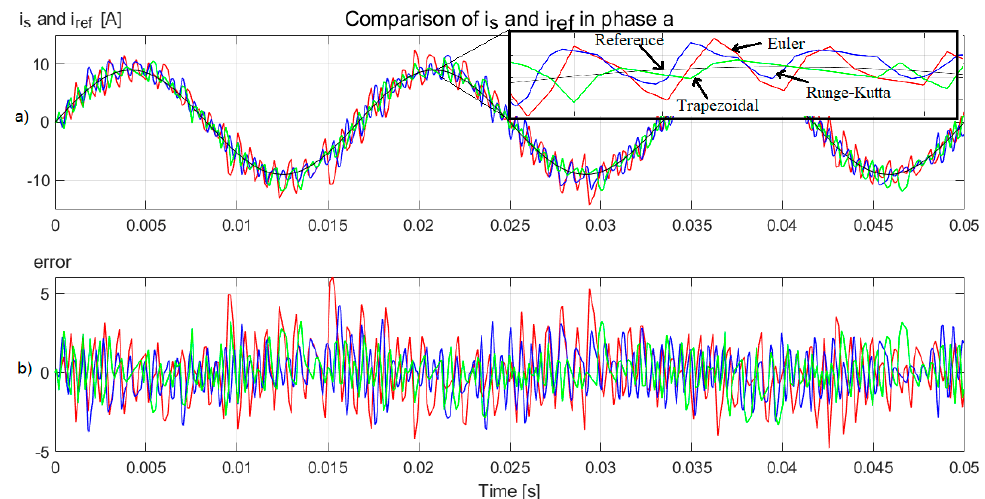
Figure 11. Comparison of i s and i ref in phase a for Euler, Runge-Kutta and firs-order trapezoidal methods with sampling period modified ( a ) Reference source current waveform i ref and measured current waveform, i s , in phase a using Euler, Runge–Kutta, and first-order trapezoidal approximations, for T s = 100 μ s; ( b ) error magnitude.